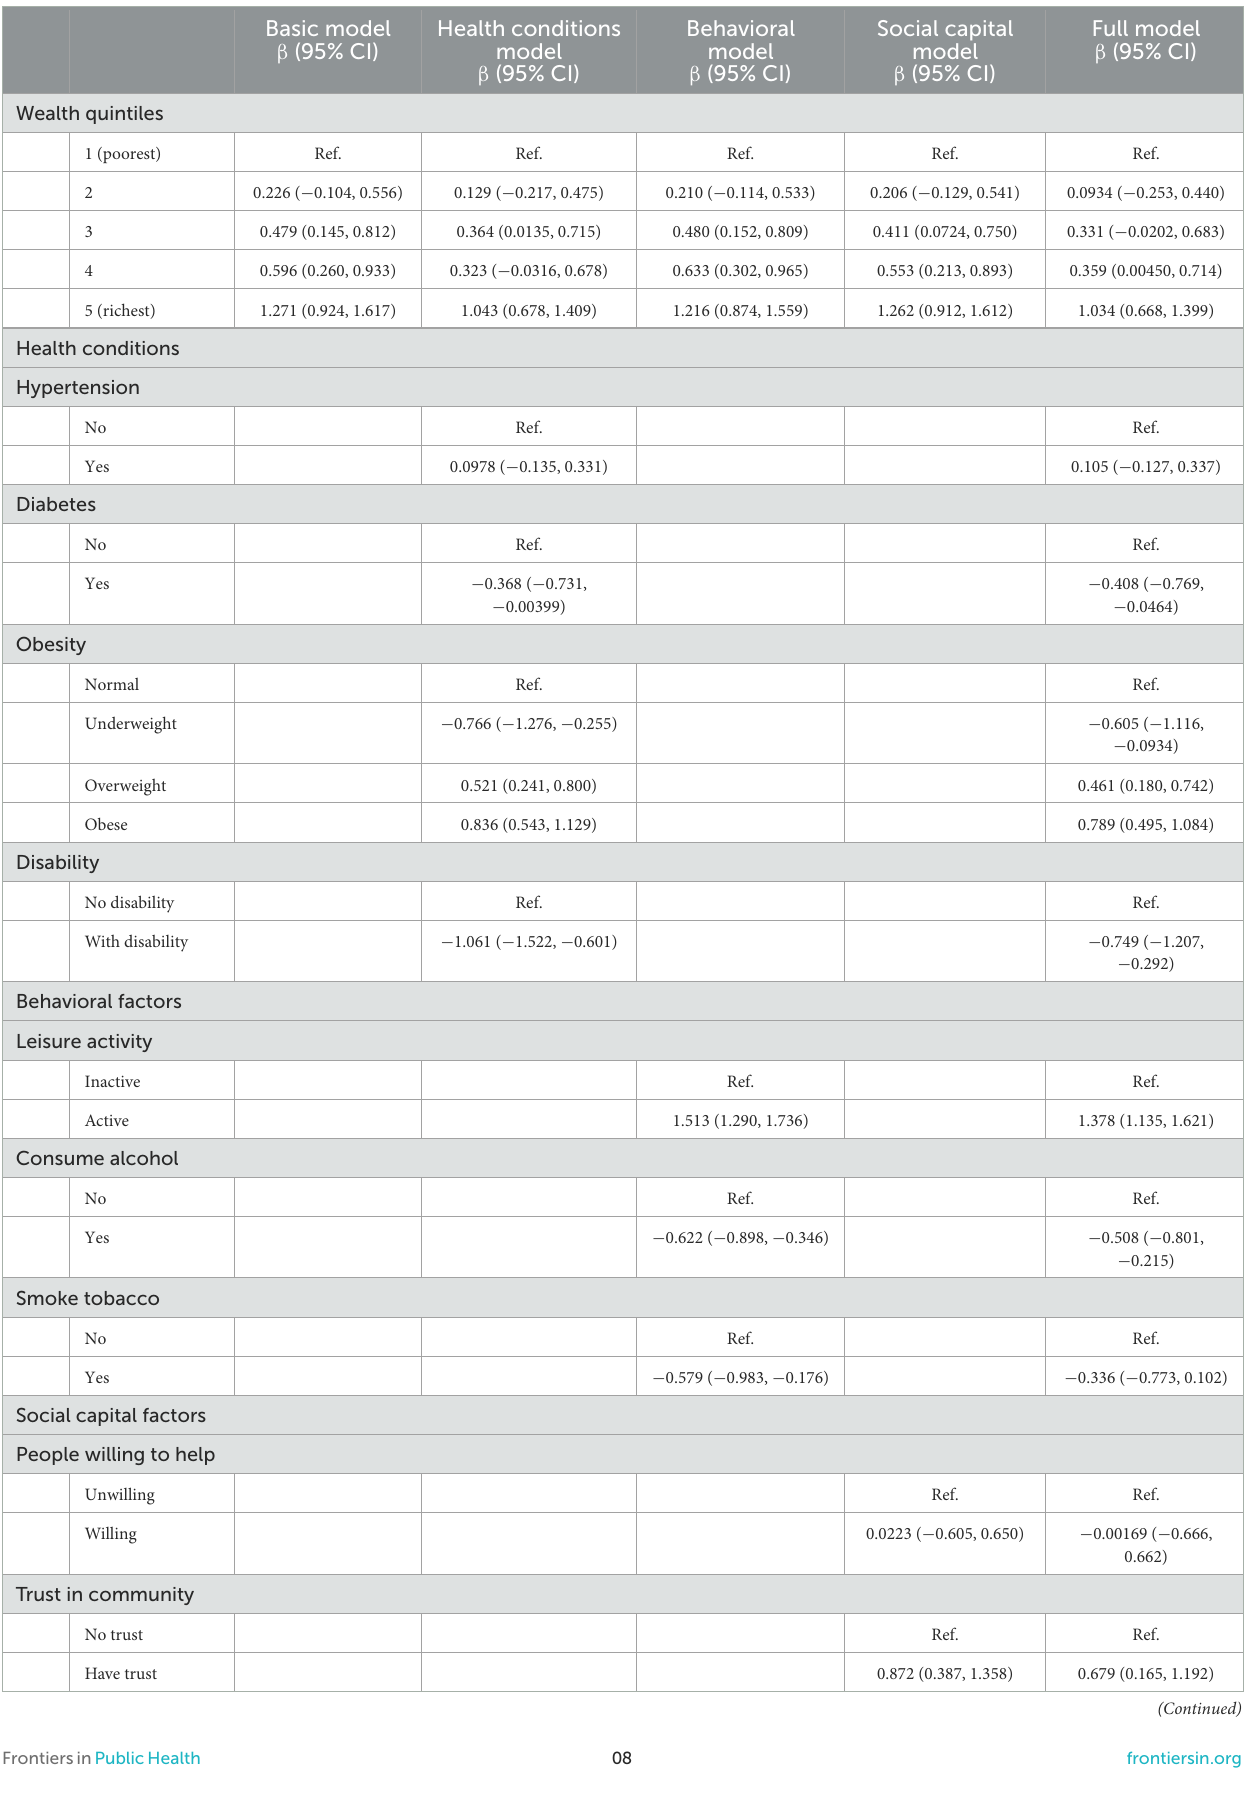
TABLE 2 Associations between socioeconomic position and cognitive function, adjusting for health conditions, behavioral and social capital factors, as well as potential